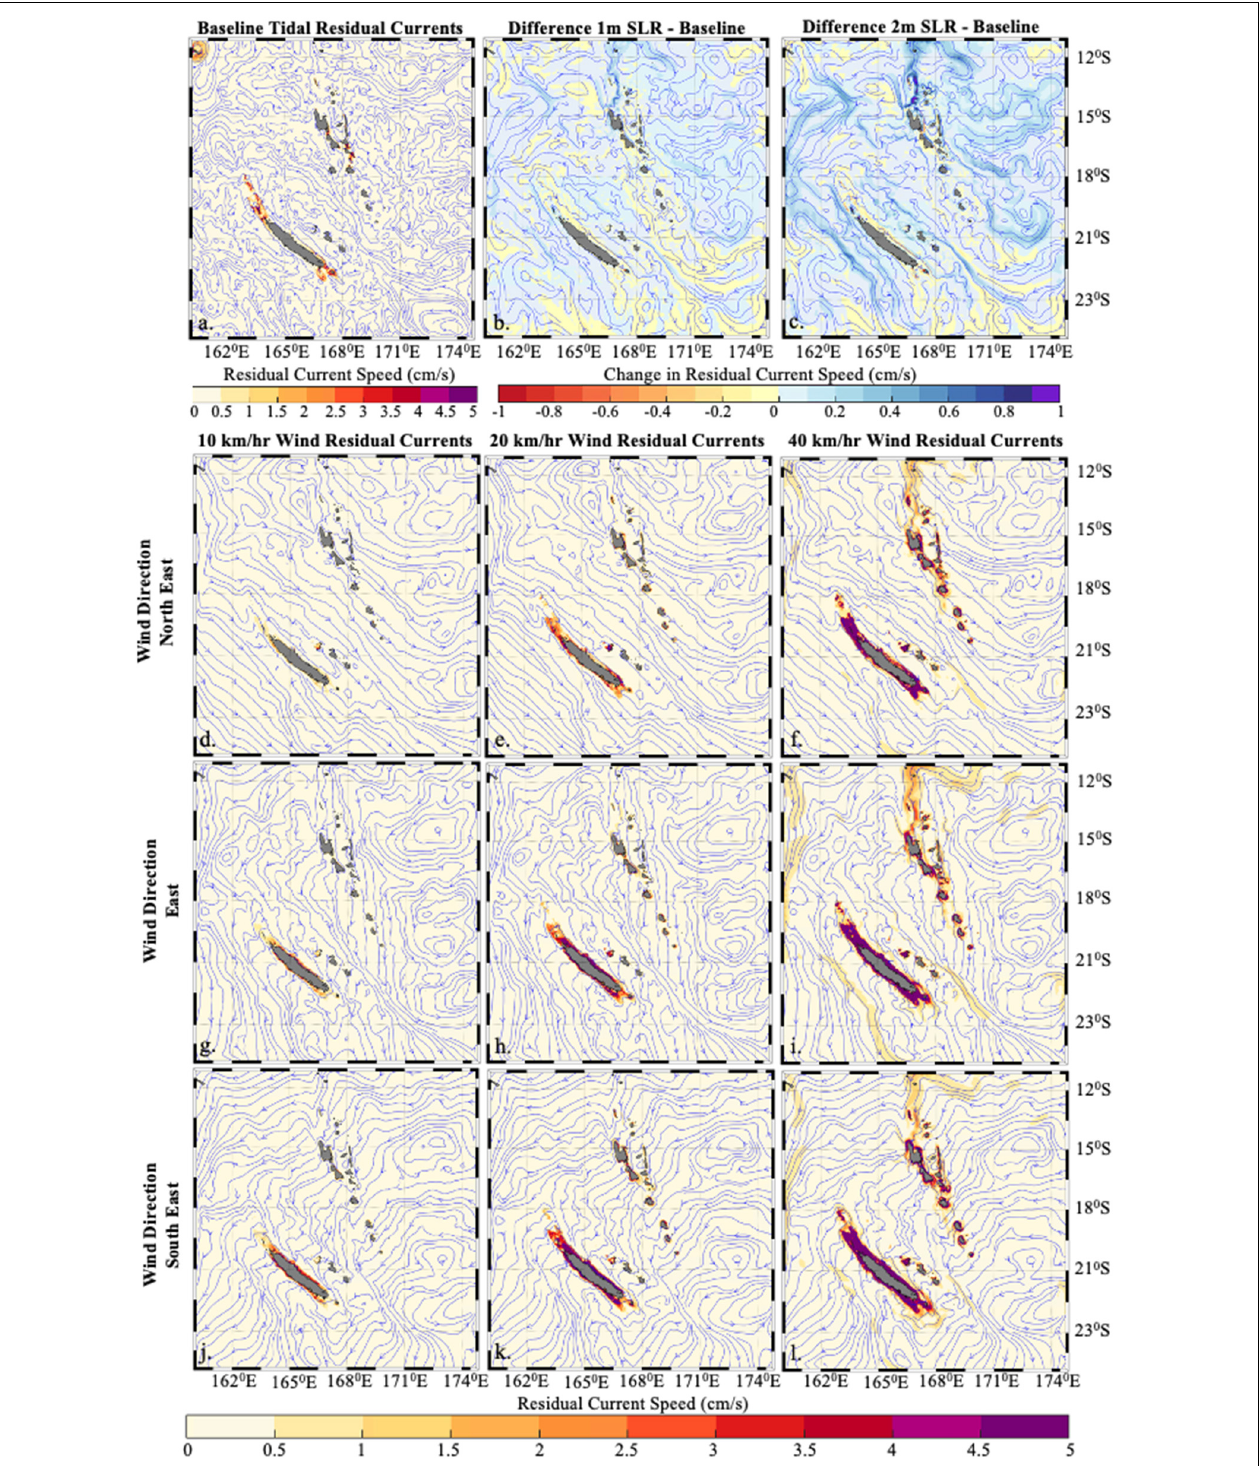
FIGURE 7 | Tidal residual current speeds (cm/s), with current patterns indicated by streamlines, across the whole model domain (a) . Change in residual current speeds (cm/s) and patterns under 1 m SLR (b) and 2 m SLR (c) . Wind residual current speeds (cm/s) and patterns under 10 km/h (d) , 20 km/h (e) , and 40 km/h (f) northeast winds. Wind residual current speeds (cm/s) and patterns under 10 km/h (g) , 20 km/h (h) , and 40 km/h (i) east winds. Wind residual current speeds (cm/s) and patterns under 10 km/h (j) , 20 km/h (k) , and 40 km/h (l) southeast winds. Latitudes are displayed to the right of panels (c,f,i,l) . Longitude for all panels are displayed below panels (a–c,j–l)